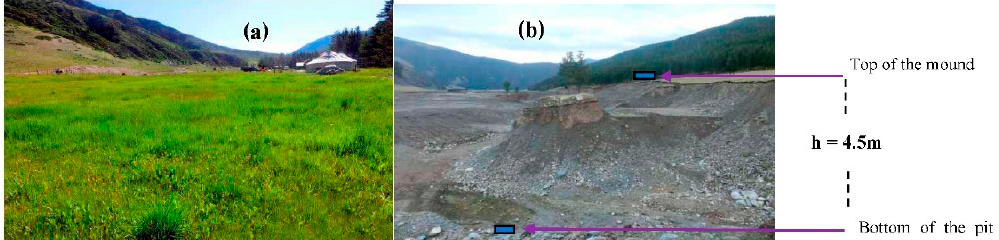
Figure 2. Original grassland ( a ) and abandoned gold mine ( b ).